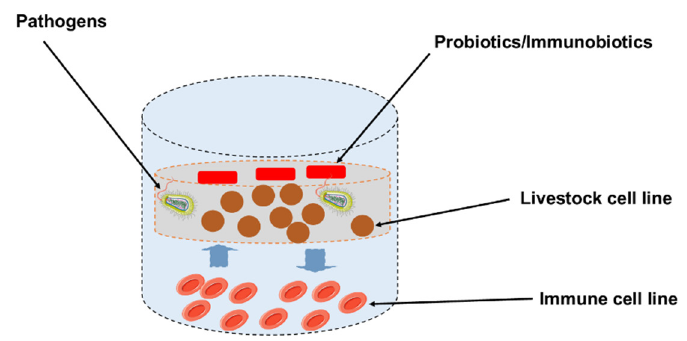
Figure 2. The in vitro cellular research model for the assessment of immunomodulatory function of probiotics/immunobiotic in